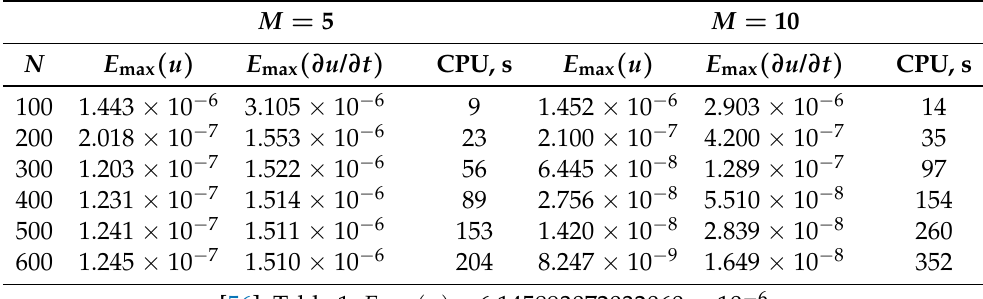
Table 6. The MAE and the elapsed time versus the N at t = 1 using M = 5 (left) and 10